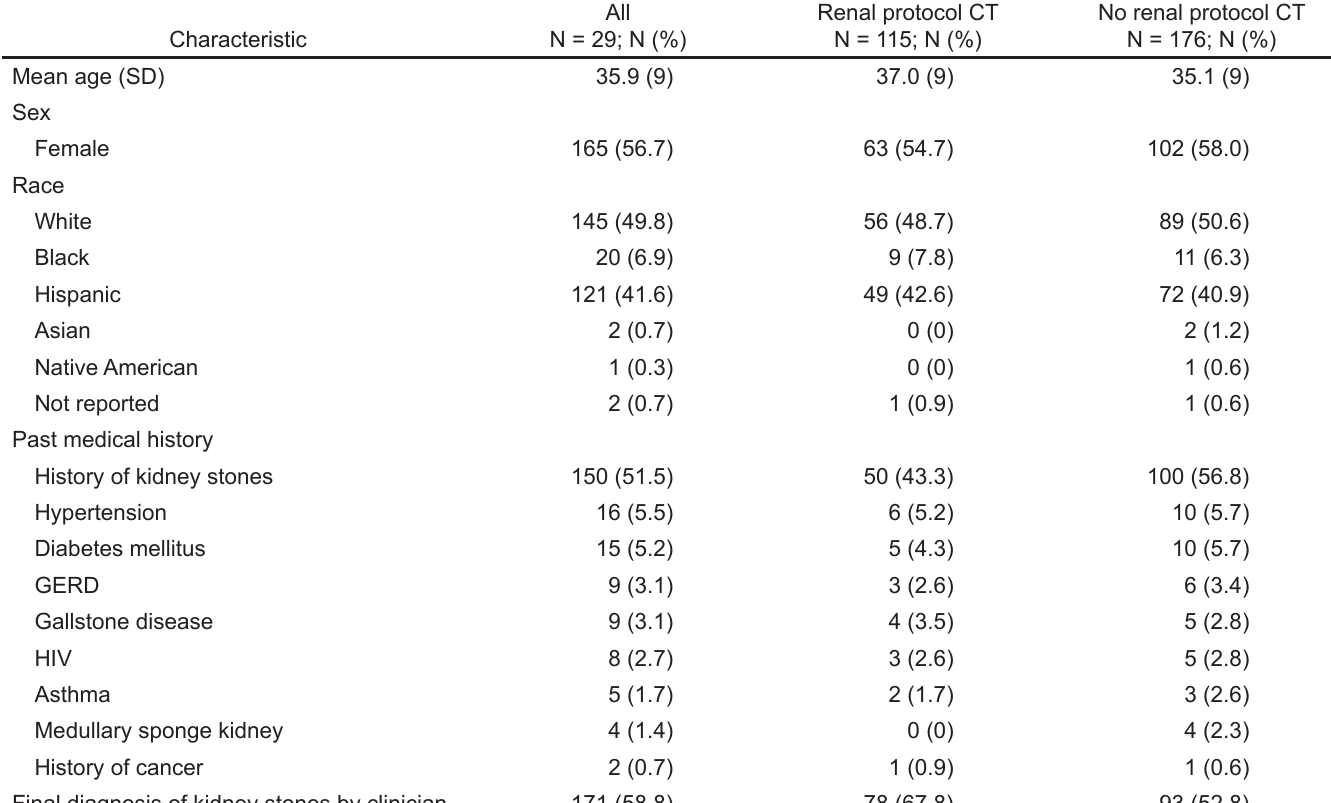
Table 1. Characteristics of